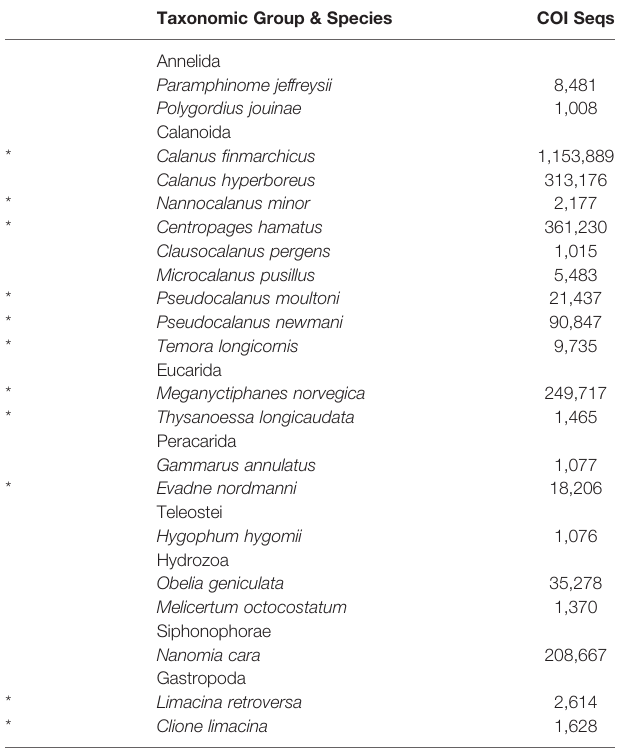
Data for these species were used for multivariate statistical analysis of patterns of zooplankton diversity among years and EcoMon regions. Asterisks (*) indicate species that are counted by morphological (microscopic) analysis in EcoMon Survey